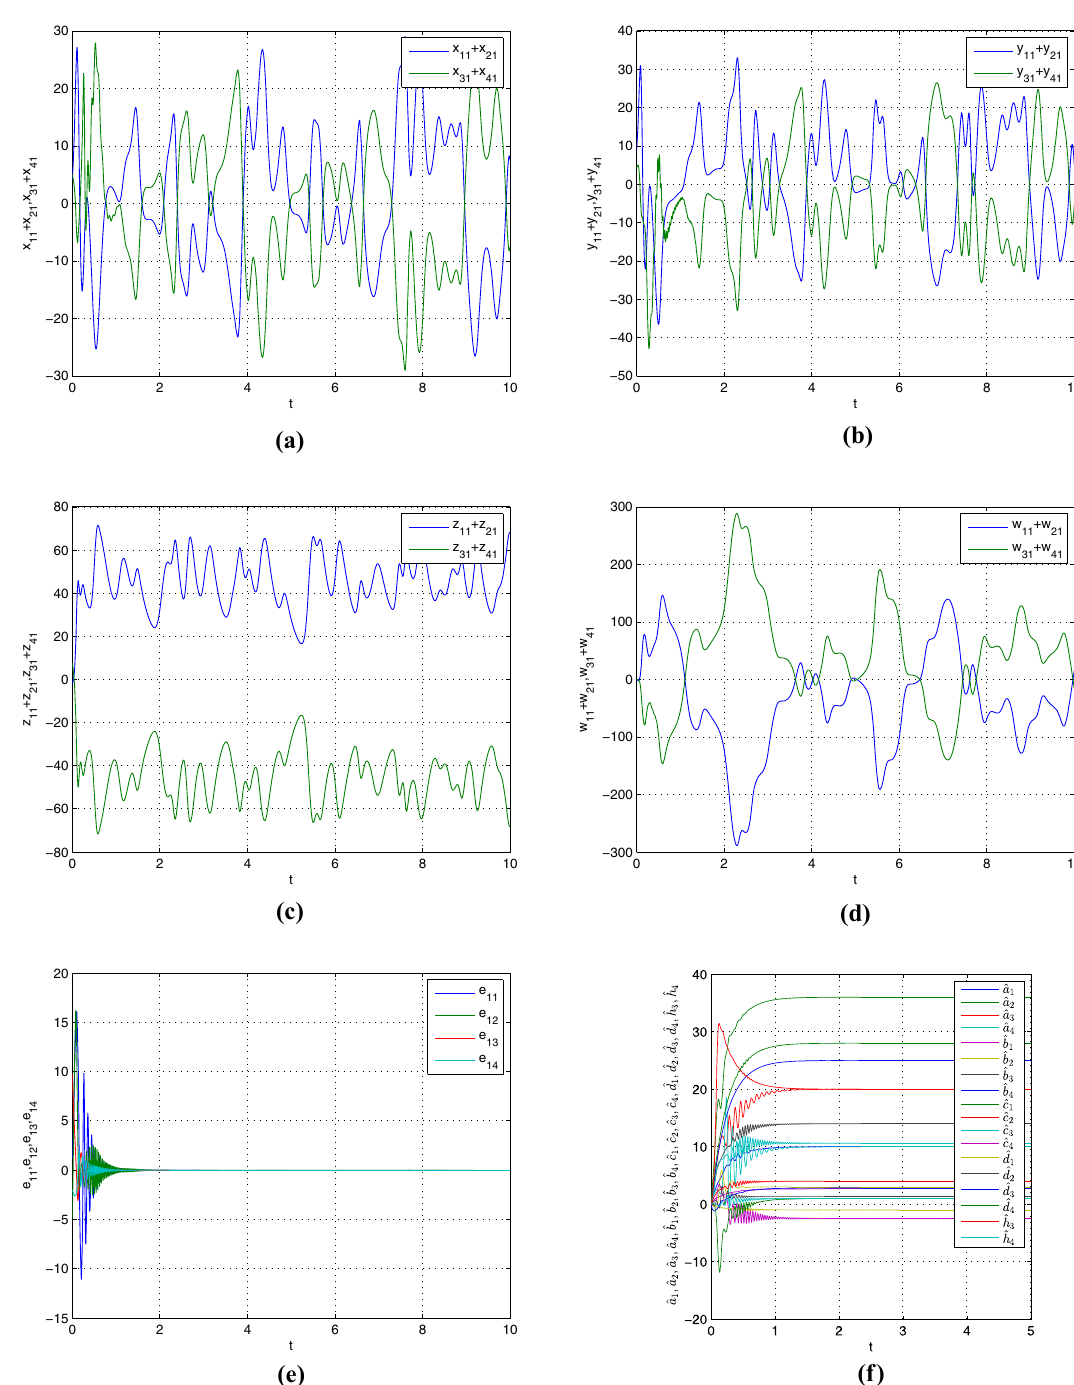
Fig. 4 Anti-synchronization of hyperchaotic systems a between x 11 ( t ) + x 21 ( t ) and x 31 ( t ) + x 41 ( t ) , b between y 11 ( t ) + y 21 ( t ) and y 31 ( t ) + y 41 ( t ) , c between z 11 ( t ) + z 21 ( t ) and z 31 ( t ) + z 41 ( t ) , d between w 11 ( t ) + w 21 ( t ) and w 31 ( t ) + w 41 ( t ) , e synchronization errors e 11 , e 12 , e 13 , e 14 , f parameter estimation